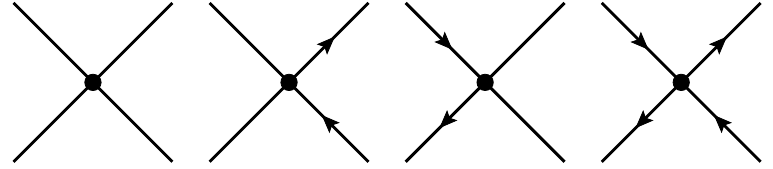
Figure 10 . The zero-range interaction vertices for w 0 w 0 ! w 0 w 0 , w 0 w 0 ! w + w (cid:0) , w + w (cid:0) ! w 0 w 0 , and w + w (cid:0) ! w + w (cid:0) . The corresponding Feynman rules are (cid:0) i ( (cid:14) ac (cid:14) bd (cid:0) (cid:14) ad (cid:14) bc ) = 2 multiplied by (cid:21) 00 , (cid:21) 01 , (cid:21) 01 , and (cid:21) 11 , respectively, where a and b are Pauli spinor indices for the incoming lines while c and d are Pauli spinor indices for the outgoing